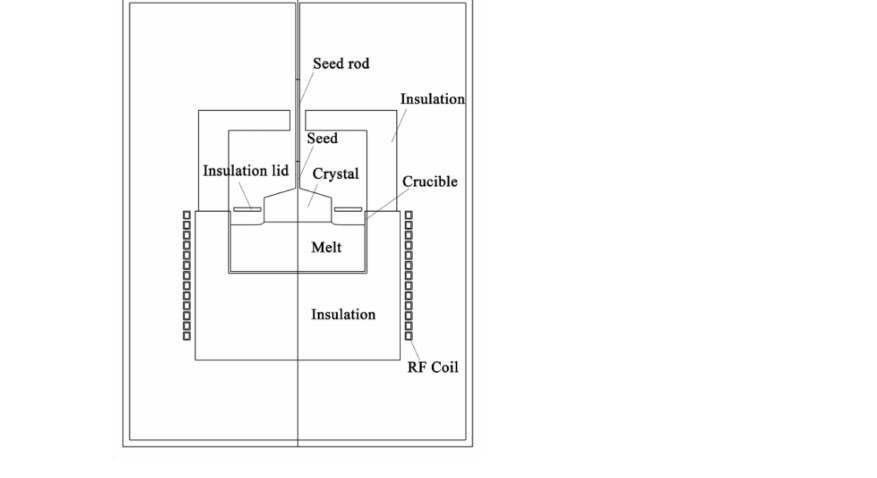
Figure 1. Schematic diagram of CZ system for 4-inch β -Ga 2 O 3 single crystal